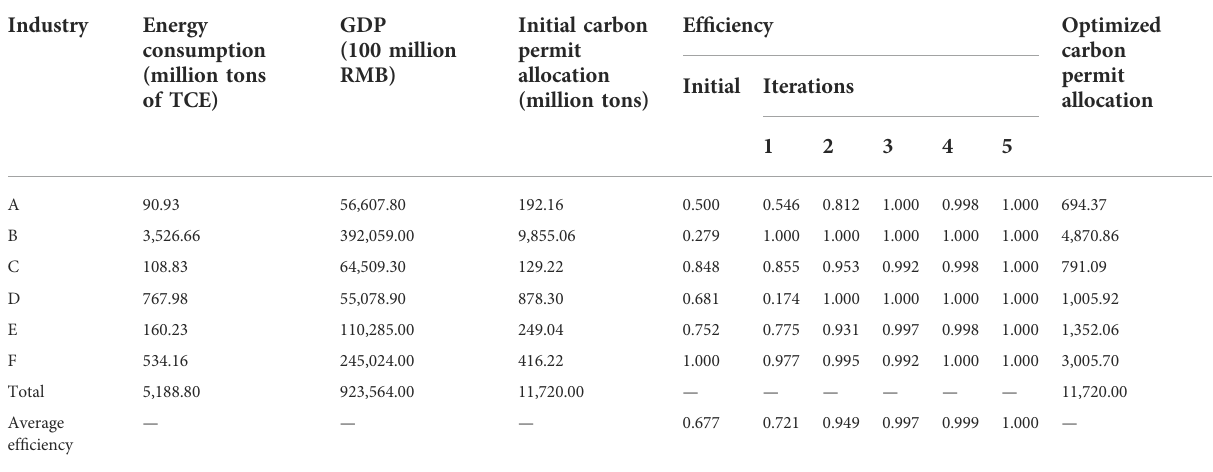
TABLE 6 Optimization of carbon permit allocation in the basic scenario.